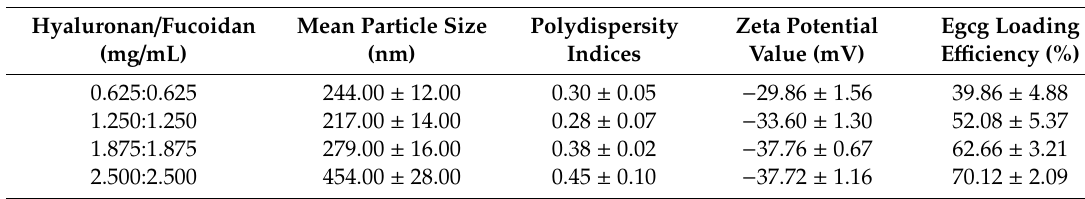
Table 1. E ff ects of hyaluronan / fucoidan proportions on particle size, polydispersity indices, zeta potential values, and drug-loading e ffi ciency of ( − )-epigallocatechin 3-gallate (EGCG) loaded hyaluronan / fucoidan / polyethylene glycol-grafted gelatin (PEG-gelatin) nanoparticles ( n =